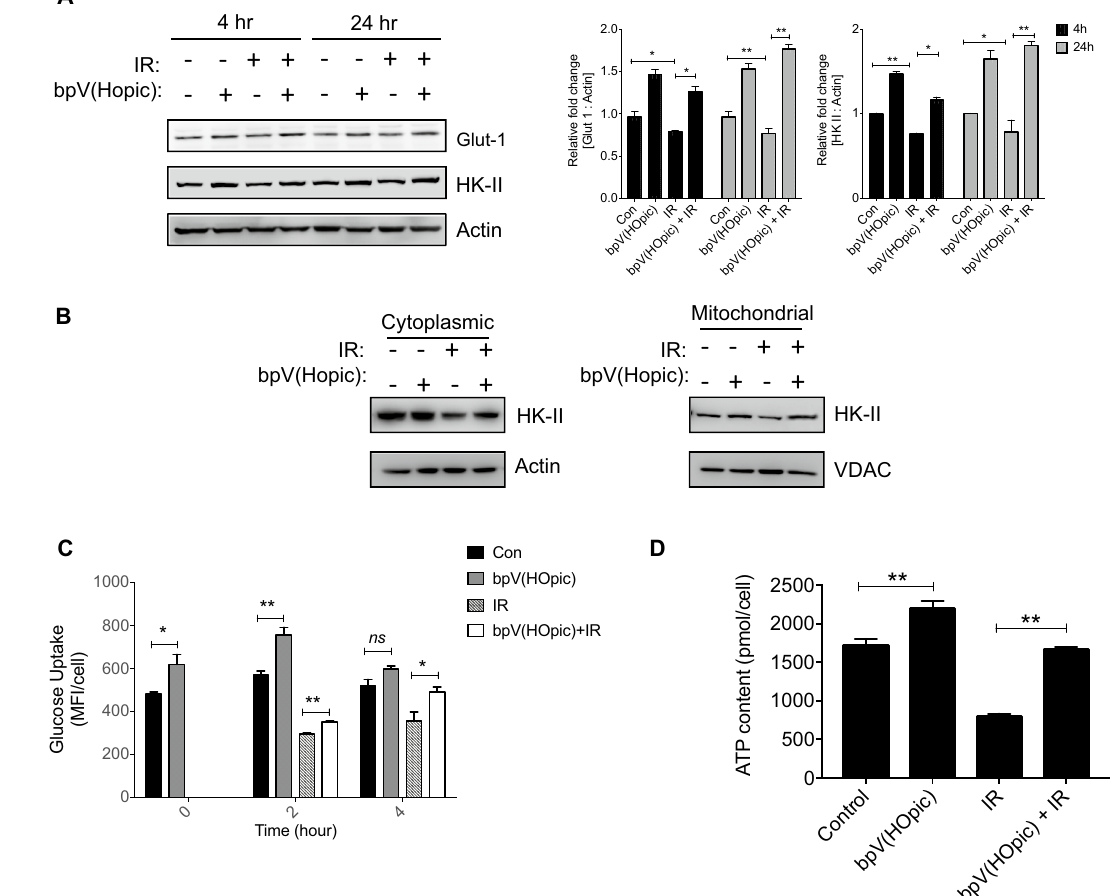
Figure 6. bpV(HOpic) protects cells against IR through AKT-induced enhanced glycolysis. ( A ) Effect of bpV(HOpic) on the levels of key glycolysis proteins in irradiated NIH-3T3 cells. Inset bar charts represent densitometry analysis of proteins normalized to Actin control. ( B ) Effect of bpV(HOpic) on the mitochondrial localization of Hexokinase II in NIH-3T3 cells at 24-h post IR exposure. ( C ) Glucose uptake in bpV(HOpic) pretreated 4 Gy irradiated NIH-3T3 assessed at indicated timepoints with 2-NBDG and flow cytometry. Control and bpV(HOpic) groups at 0 h represent the status of glucose uptake at the time of irradiation, represented as the mean fluorescent intensity of 2-NBDG uptake. ( D ) Effect of bpV(HOpic) pretreatment on the cellular ATP content of irradiated NIH-3T3 cells. Error bars are mean ± SD (n = 4) from two independent experiments. * p < 0.05; ** p < 0.01; ns =